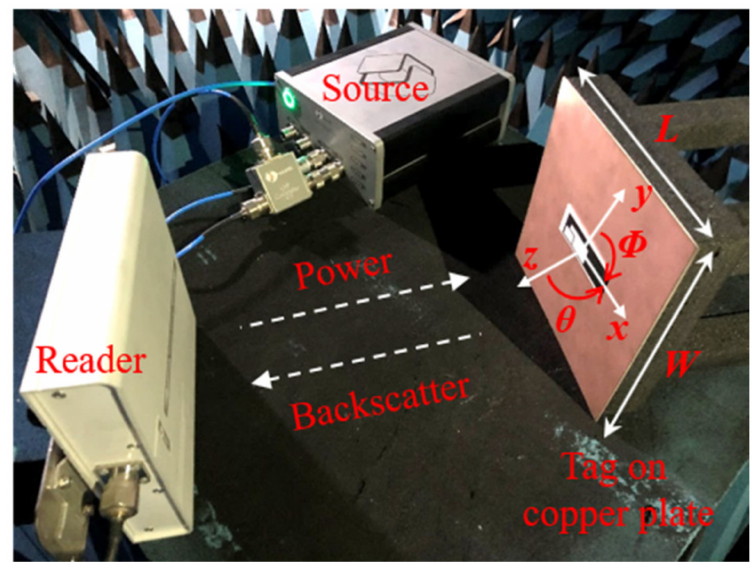
Figure 11. The tag under test in the anechoic chamber.